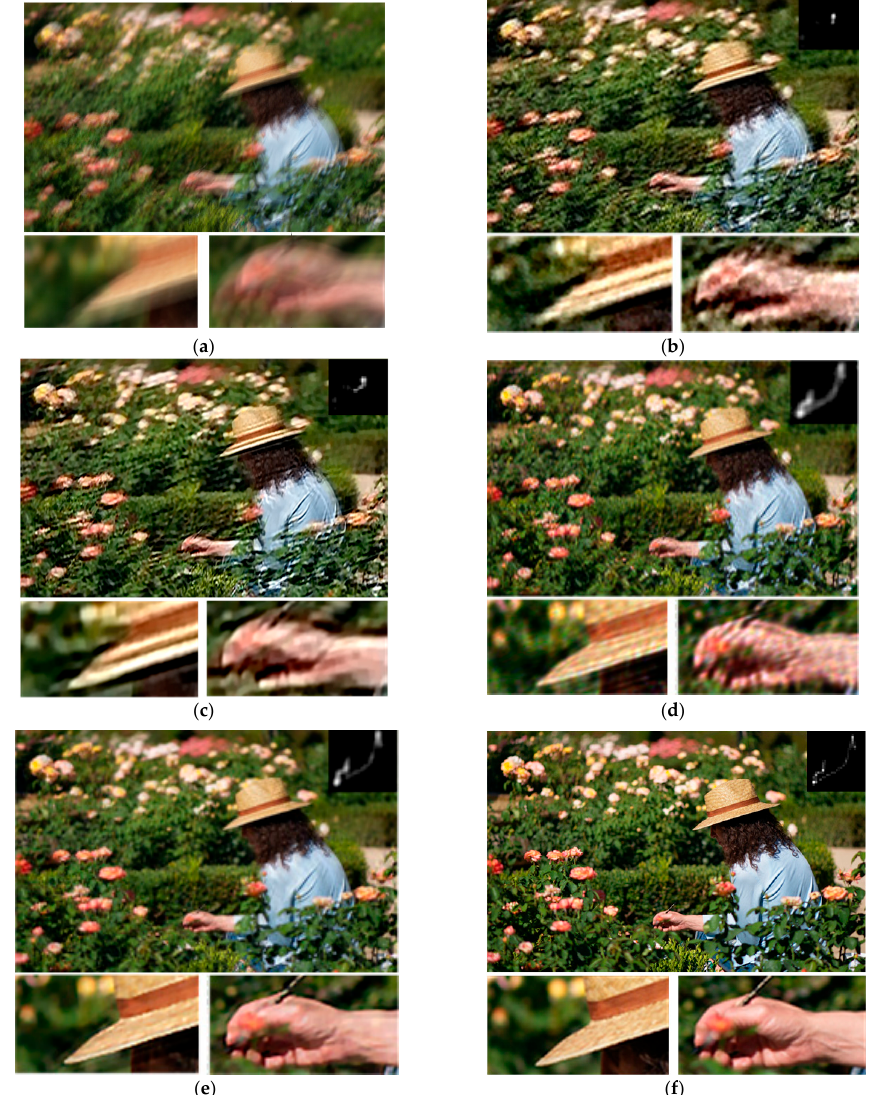
Figure 9. Comparison of different restoration algorithms on blur image with rich textures and small details. ( a ) Blurred image; ( b ) result of Fergus et al. [3]; ( c ) result of Shan et al. [4]; ( d ) result of Xu and Jia [7]; ( e ) our result; and ( f ) the ground truth image and blur kernel. The size of blur kernel is 27 × 27.